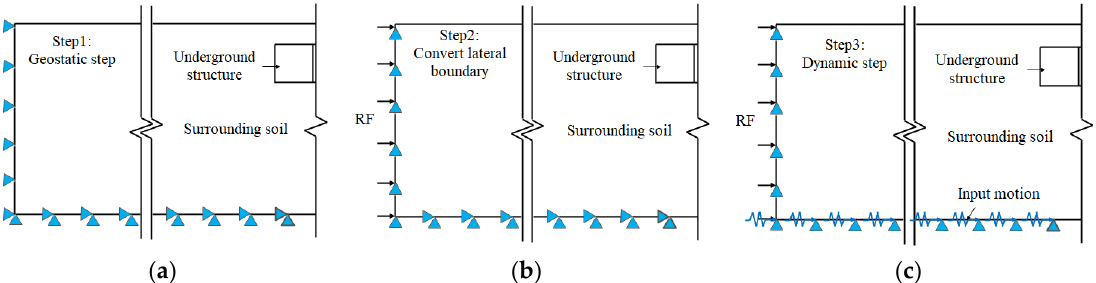
Figure 6. Transformation of boundary condition during analysis: ( a ) geostatic step; ( b ) convert lateral boundary; and ( c ) dynamic step.